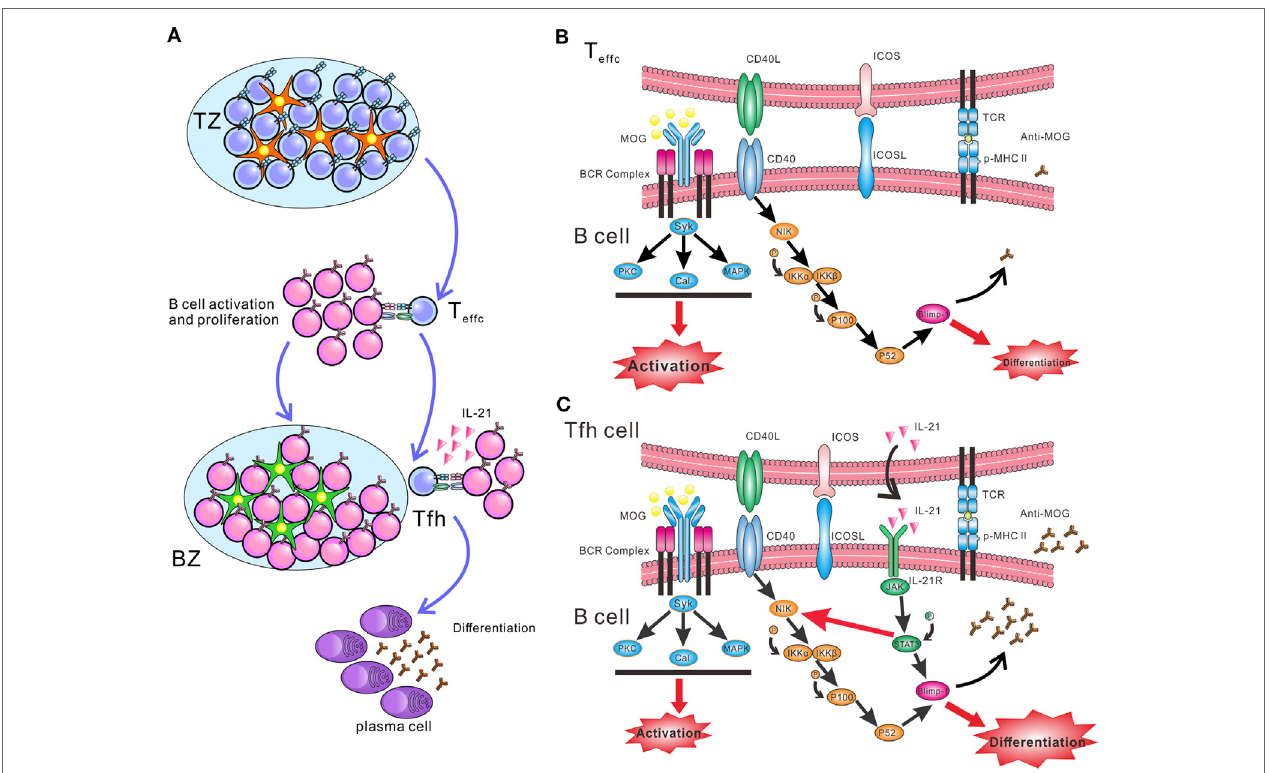
FigUre 7 | Schematic diagram of interaction between T follicular helper (Tfh) and B cells initiating synergetic effect of IL-21/IL-21R and CD40 ligand (CD40L)/CD40 to promote plasma cell differentiation and antibody production in EAE. (a) The process of antigen-activated T cells and B cells migrating to the B cell follicles, where enables B cells receive helper signals from Tfh cells. Red pentacle cells stand for dentritic cells and green pentacle ones for follicular dentritic cells. (B) At the T-B border, B cells receive signals from cognate CD4 + T cells to activate and proliferate. (c) Within the germinal centers (GCs), MOG-specific B cells recognize antigen and present it to Tfh cells. After receiving activation signal of MHC-peptide complex and ICOSL from B cells, Tfh cells secret large amount of IL-21 and express CD40L. IL-21 and CD40L bind to the relevant receptor and ligand on B cells, respectively. The ligation of CD40L and CD40 promote the stabilization of NF- κ B- inducing kinase (NIK), and activate the downstream pathway, which lead the formation of P52 and initiate the expression of B lymphocyte-induced maturation protein-1 (Blimp-1). IL-21 receptor activates the JAK/STAT3 pathway and phosphorylated STAT3 (p-STAT3) promotes the expression of Blimp-1. Moreover, P-STAT3 could also upregulate the expression of NIK, probably through stimulating the de novo synthesis of NIK (red thin arrow). Thus, the signal provided by IL-21 and CD40L synergistically facilitates the differentiation of B cells and autoantibody